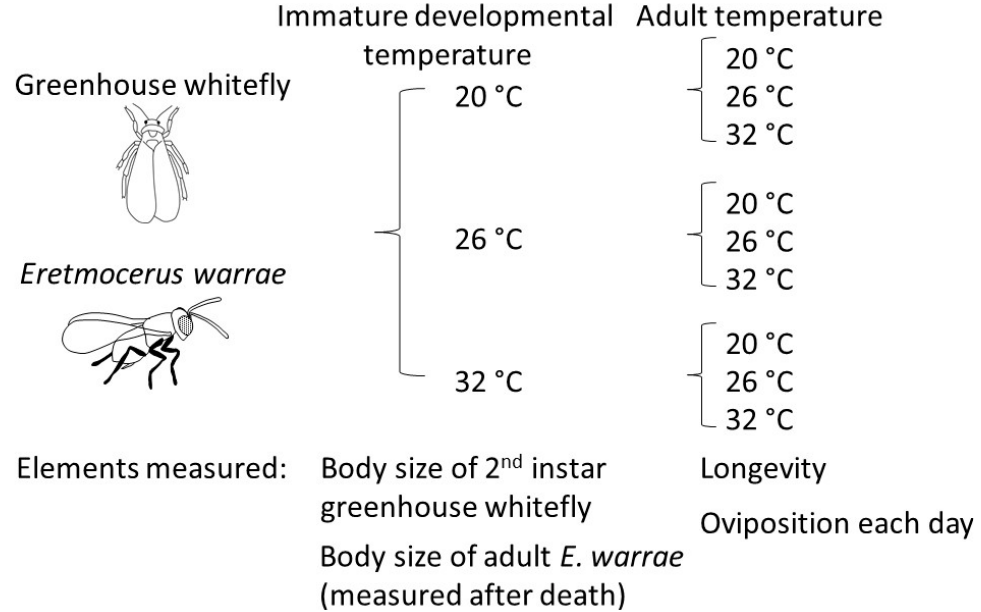
Figure 1. Summary of experimental design.